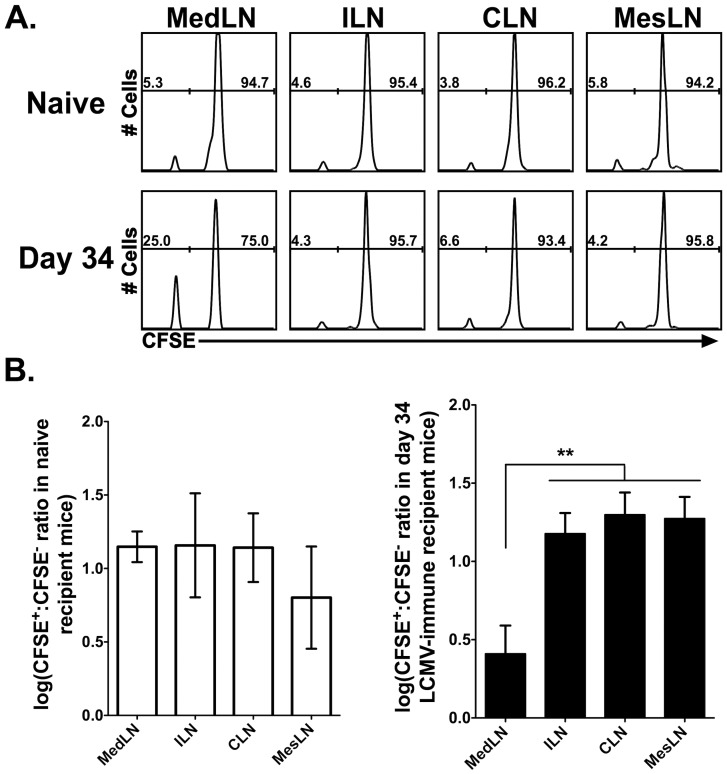
CD62L− effector memory CD8 T cells preferentially traffic to the draining MedLN.CD62L+ and CD62L− memory P14 cells were isolated from LCMV-immune mice. CD62L+ cells were CFSE-labeled and mixed with unlabeled CD62L− P14 cells and transferred into either naïve or day 34 LCMV infected mice. 72 h post-transfer, LNs were harvested and transferred cells (CD8+Thy1.1+) were examined for their ratios in naïve mice or day 34 LCMV-infected mice. (A) Representative histograms from naïve (top) and day 34 LCMV-infected (bottom) mice is shown from one of three experiments with 5 mice total per group. (B) Graphs depicting combined data from all experiments presented in a logarithmic scale. Na?¨ve mice are shown the open bars and day 34-LCMV mice are shown in the closed bars. **, MedLN is significantly lower (p<0.01) than the ILN, CLN and MesLN as determined by ANOVA.